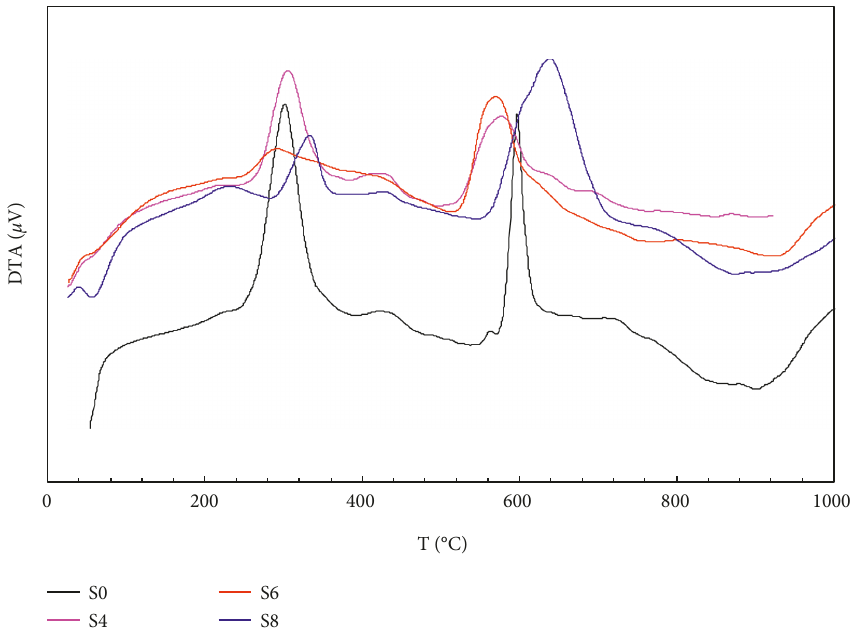
Figure 4: DTA curves of CuONPs-doped HEC samples.